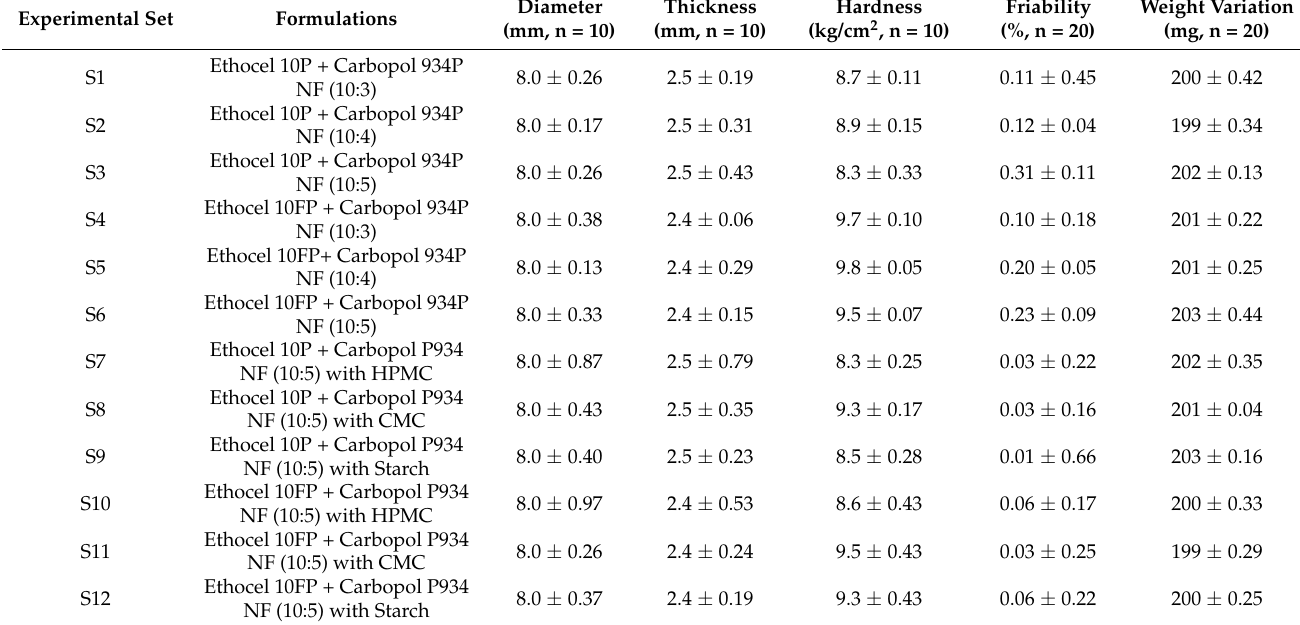
Table 3. Physical properties of the tested matrices.